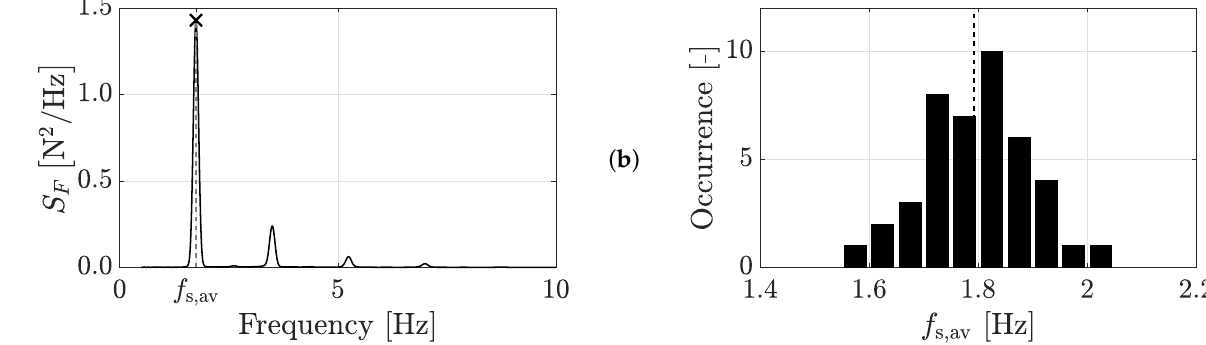
Figure 4. ( a ) PSD of the vertical contact force of the reference trial (solid line) with indication of the maximum value ( which the abscissa corresponds to the estimated average step frequency f s,av and ( b ) histogram of all the trials (bars) with indication of the group-averaged value (dashed